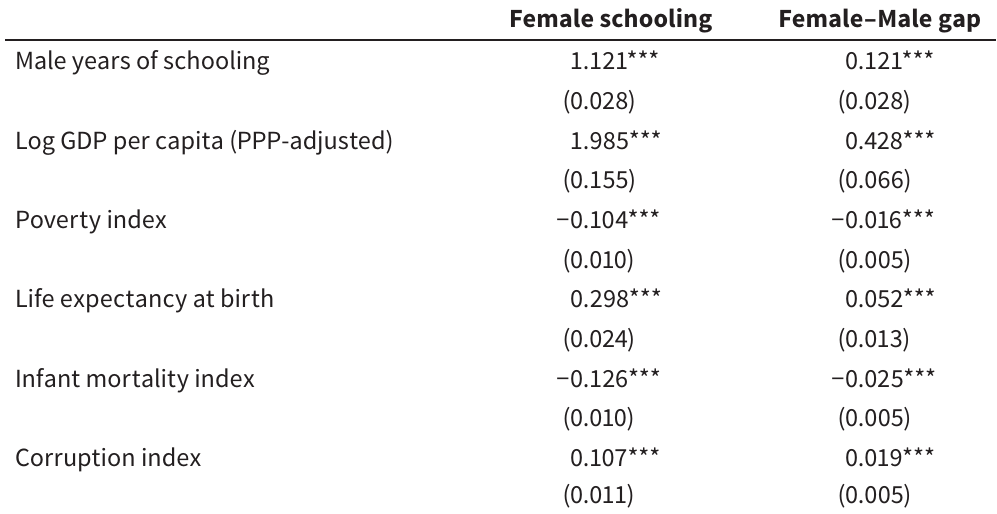
Regression of Female Schooling and Gender Gap in Schooling on Key Variables. Female